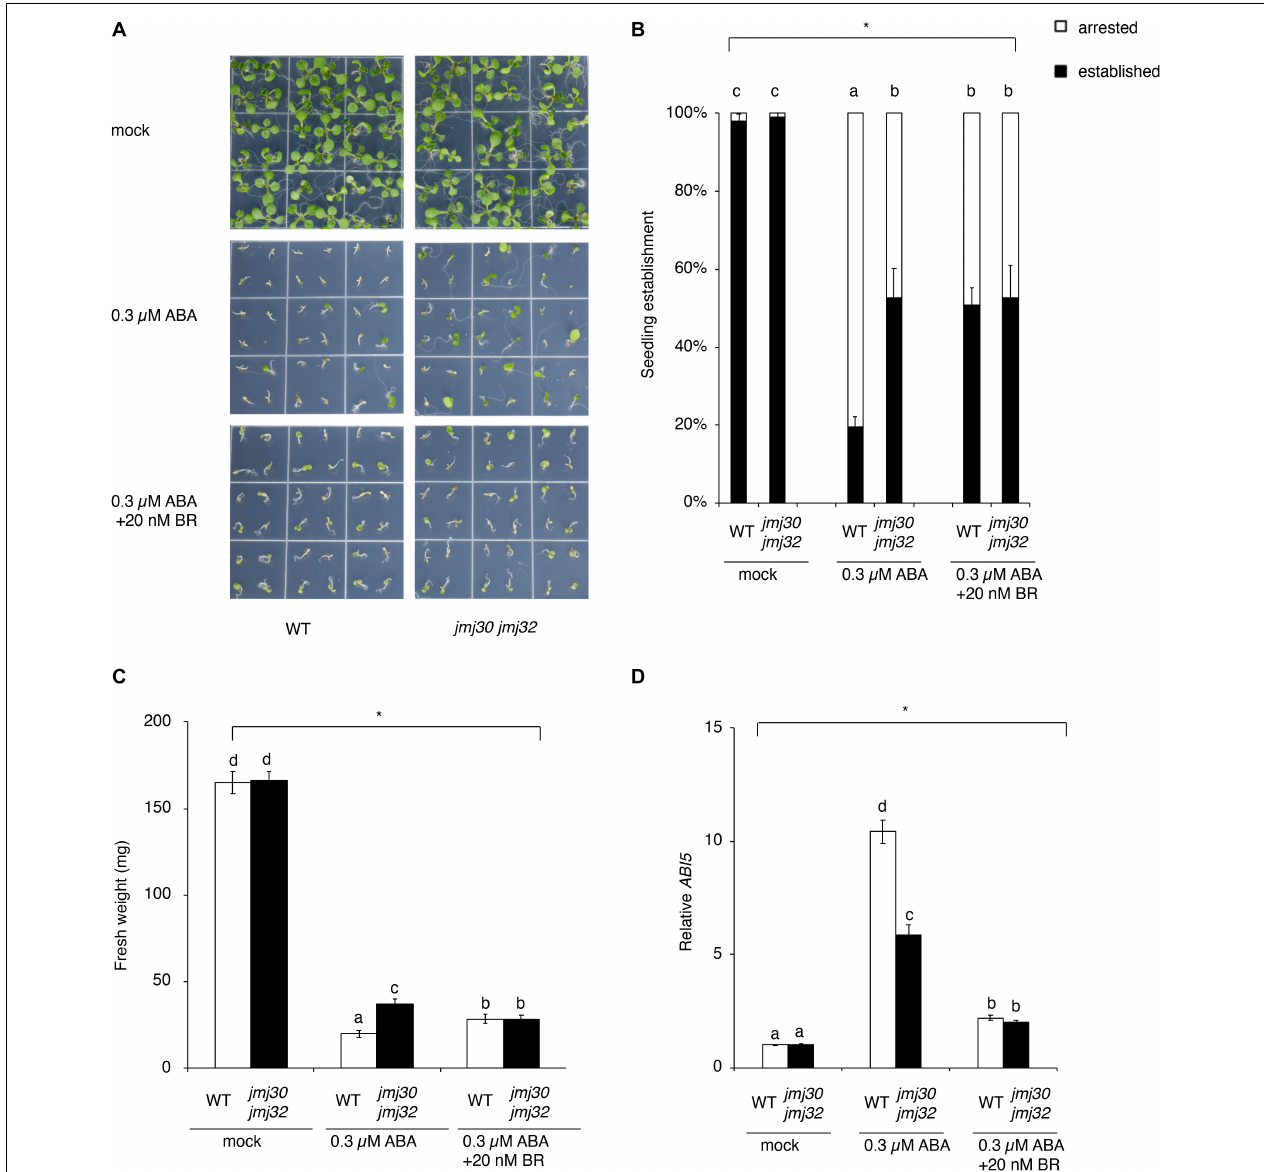
FIGURE 2 | BR blocks ABA-mediated seedling arrest during post-germination stage. (A) Representative images of the wild type and jmj30-2 jmj32-1 double mutants grown for 7 days on 1/2 MS medium (–sucrose) +0.3 µ M ABA containing 0 and 20 µ M BR. (B) Percentages of established seedlings in ABA-treated wild-type and jmj30-2 jmj32-1 plants in the absence and presence of BR. Asterisks indicate significant differences based on one-way ANOVA test. p < 0.05. Different letters indicate significant differences, whereas the same letters indicate non-significant differences based on post hoc Tukey’s HSD test. p < 0.05. (C) Measurement of fresh weight in ABA-treated wild-type and jmj30-2 jmj32-1 plants in the absence and presence of BR. Asterisks indicate significant differences based on one-way ANOVA test. p < 0.05. Different letters indicate significant differences, whereas the same letters indicate non-significant differences based on post hoc Tukey’s HSD test. p < 0.05. (D) ABI5 expression in wild-type and jmj30 - 2 jmj32 - 1 plants with and without ABA/BR by RT-qPCR. Asterisks indicate significant differences based on one-way ANOVA test. p < 0.05. Different letters indicate significant differences, whereas the same letters indicate non-significant differences based on post hoc Tukey’s HSD test. p <